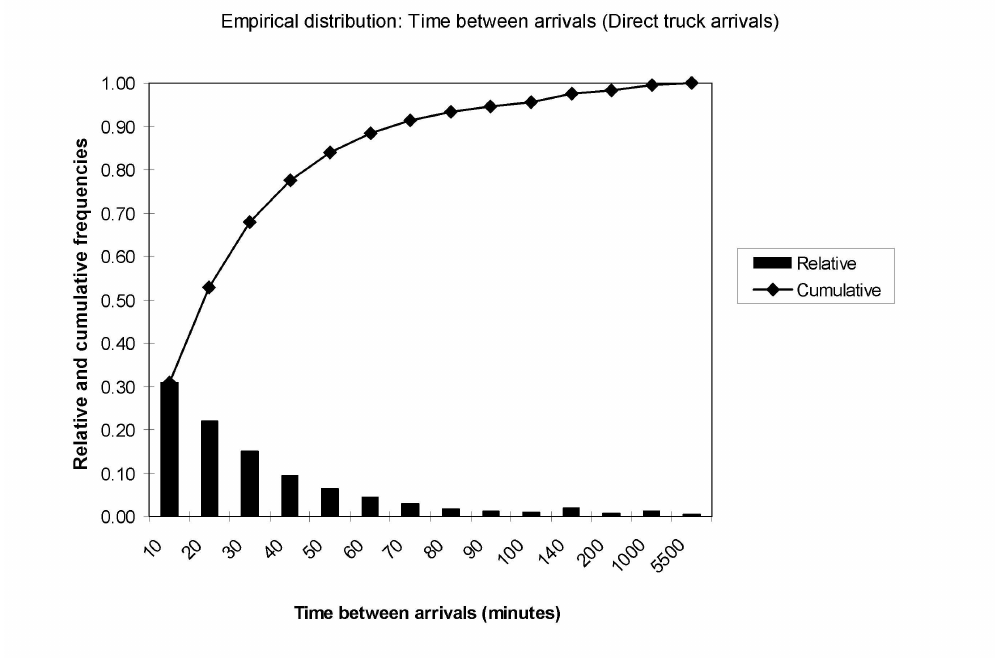
Figure 2: Histogram and empirical distribution: Time between arrivals (Direct).